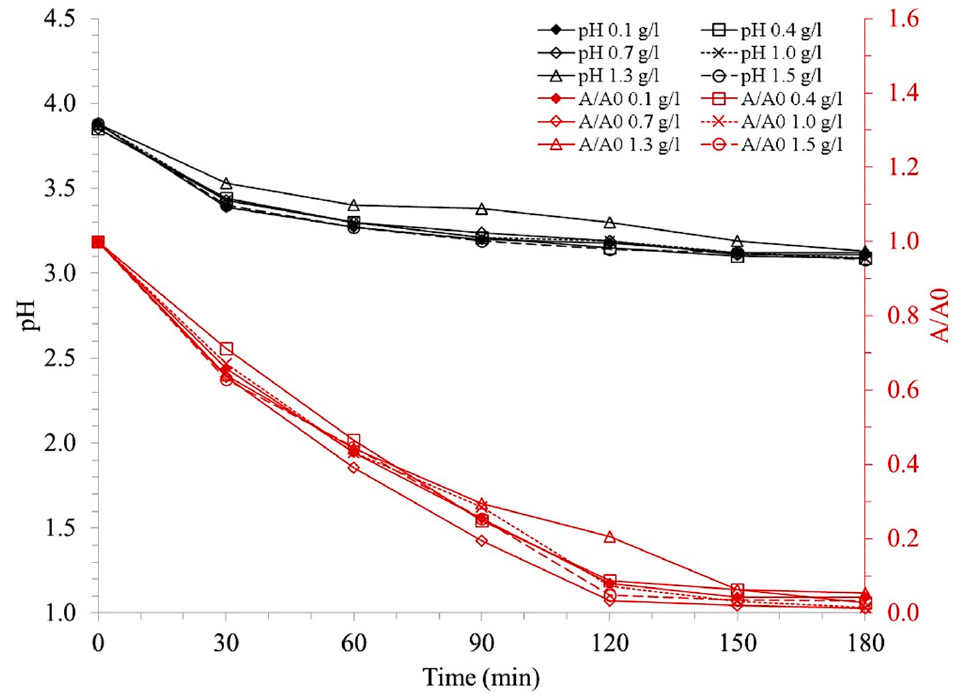
Figure 5. E ff ect of ilmenite loading on discoloration (A/A 0 ) and pH. ([H 2 O 2 ] = 10 mM, pH 0 = 3.8, UV-C Light).